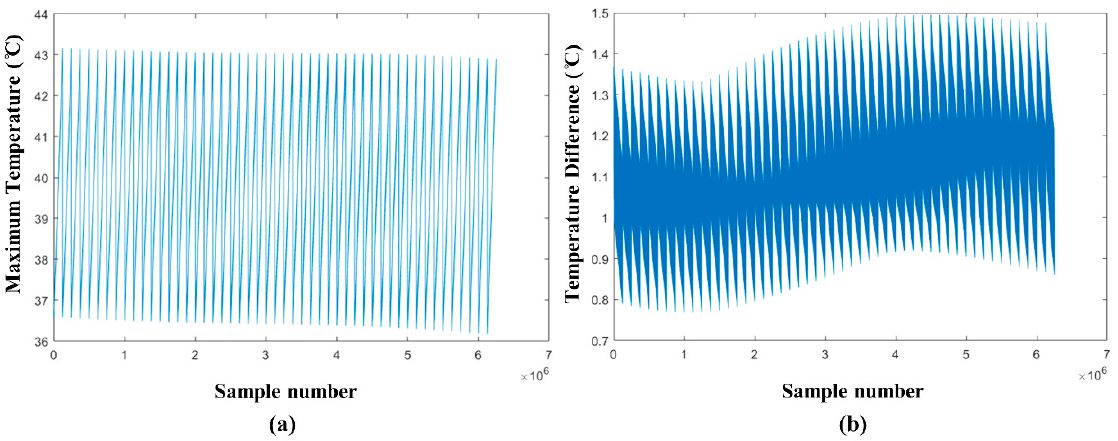
Figure 8. ( a ) Maximum temperature and ( b ) temperature difference of the battery pack for different input combinations.